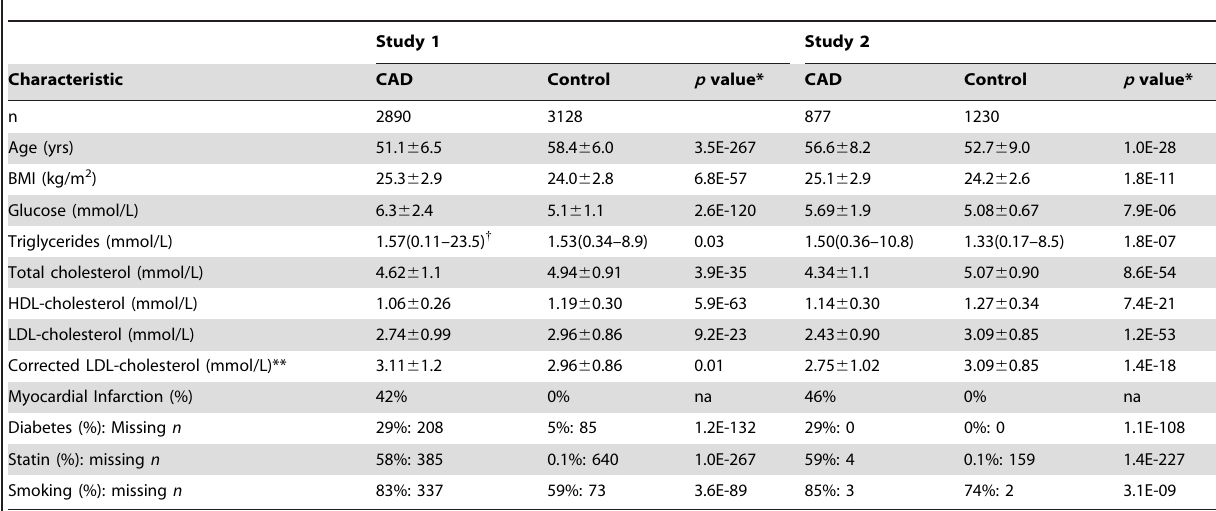
Table 1. Characteristics of the participants in Studies 1 and